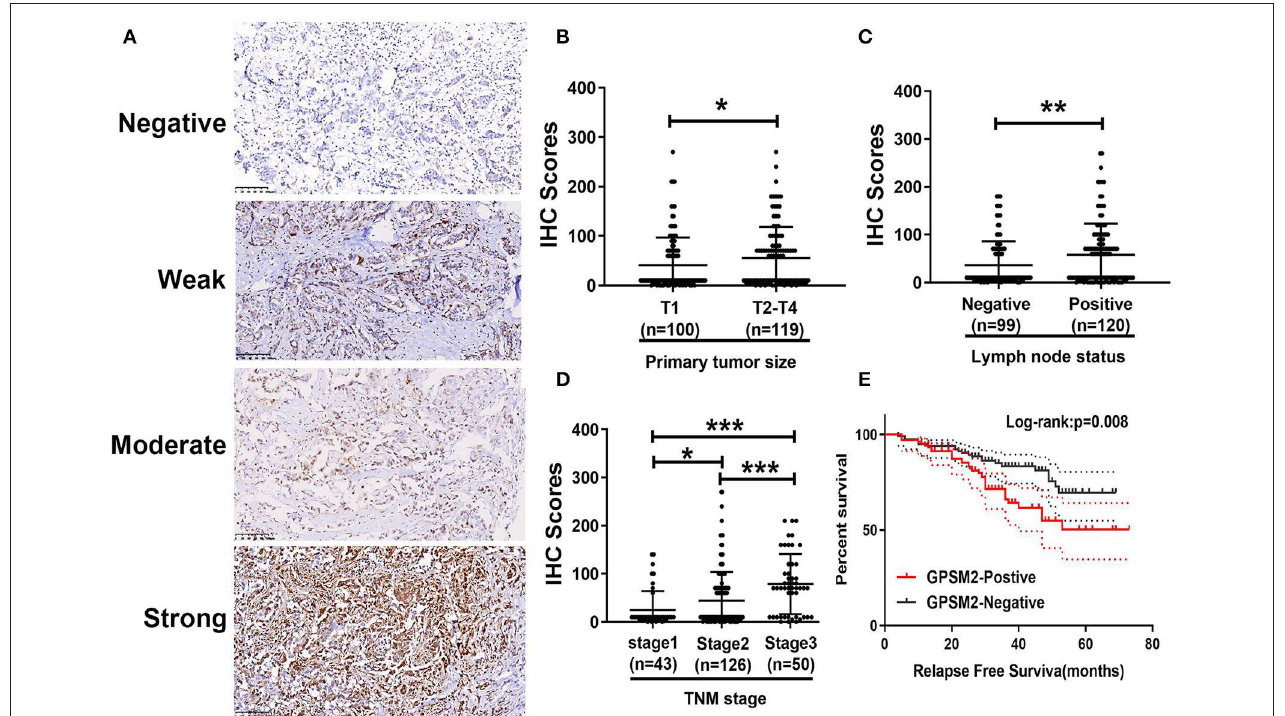
FIGURE 1 | The expression of GPSM2 correlates with clinical features and indicates prognosis in breast patients. (A) Representative images of GPSM2 staining in human breast cancer tissue samples: “–” (negative staining), “ + ” (weak staining), “ ++ ” (moderate staining), and “ + + + ” (strong staining); (B) GPSM2 IHC scores of samples with advanced tumor sizes were significantly increased; (C) GPSM2 IHC scores of samples related to positive lymph node status were significantly increased; (D) GPSM2 IHC staining scores were significantly increased with advanced TNM stage; (E) Kaplan-Meier survival analysis and log-rank test indicated that positive of GPSM2 expression was associated with poor overall survival ( p = 0.008); * p < 0.05, ** p < 0.01, and *** p < 0.001 (vs. control